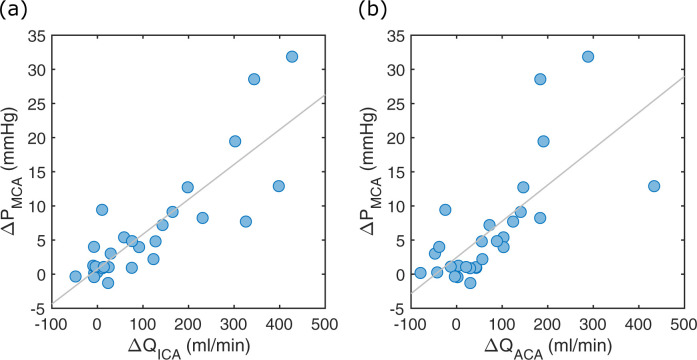
ICA and ACA flow relationship to pressure.(a) The ΔPMCA versus ΔQICA. The linear correlation was r = 0.85 (p<0.001). (b) The ΔPMCA versus ΔQACA. The linear correlation was r = 0.71 (p<0.001).